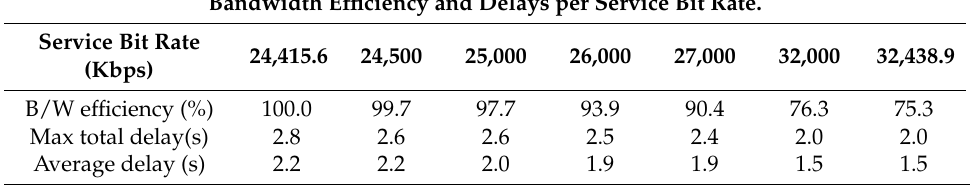
Figure 9. Simulation results of ‘DASH fast’. Table 9. Simulation results of ‘DASH fast’. Bandwidth Efficiency and Delays per Service Bit Rate. Service Bit Rate (Kbps)